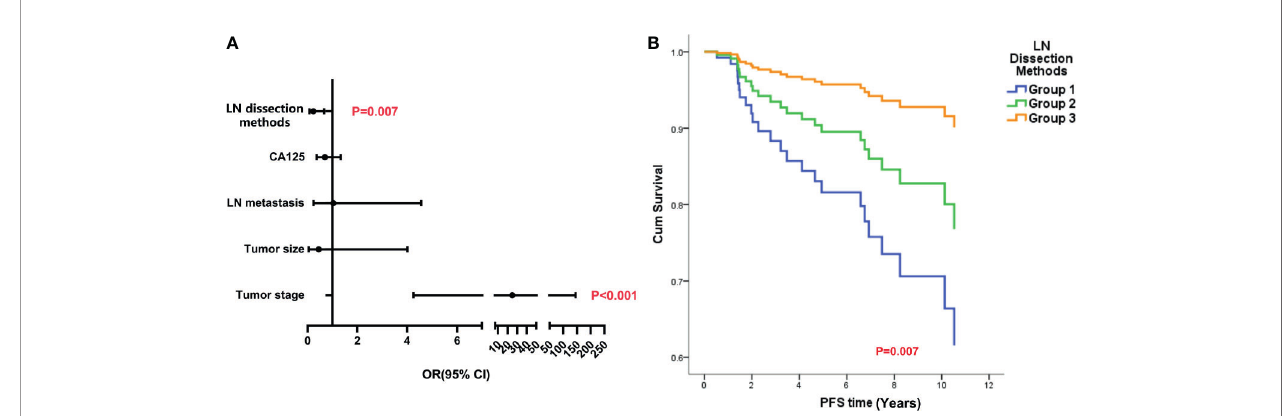
FIGURE 3 | The analysis of independent risk factors on PFS of LG-SOC. (A) The forest fi gure of Cox multiple regression for PFS of LG-SOC, including items with p-values less than 0.3 in univariate analysis. Any item in which a p-value was less than 0.05 and the 95% CI for OR did not cross 1 was considered statistically signi fi cant. The p-value of the multivariate regression model was less than 0.001. (B) The survival curves of LN dissection methods on PFS after controlling other variables by the Cox test. OR, odds ratio; 95% CI, 95% con fi dence interval of OR; PFS, progression-free survival; LG-SOC, low-grade serous ovarian cancer; LN, lymph